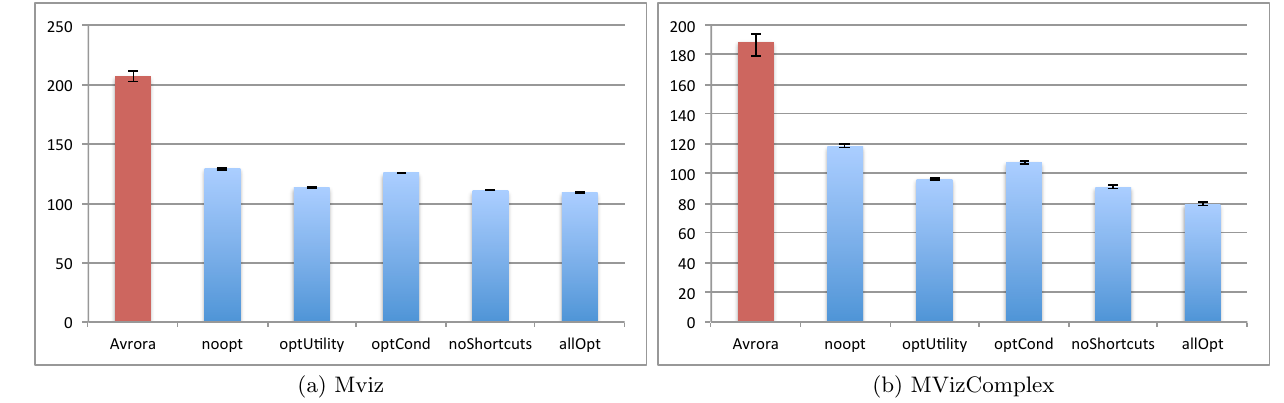
Figure 4: Network simulation performance for 16 nodes (wall time in seconds)